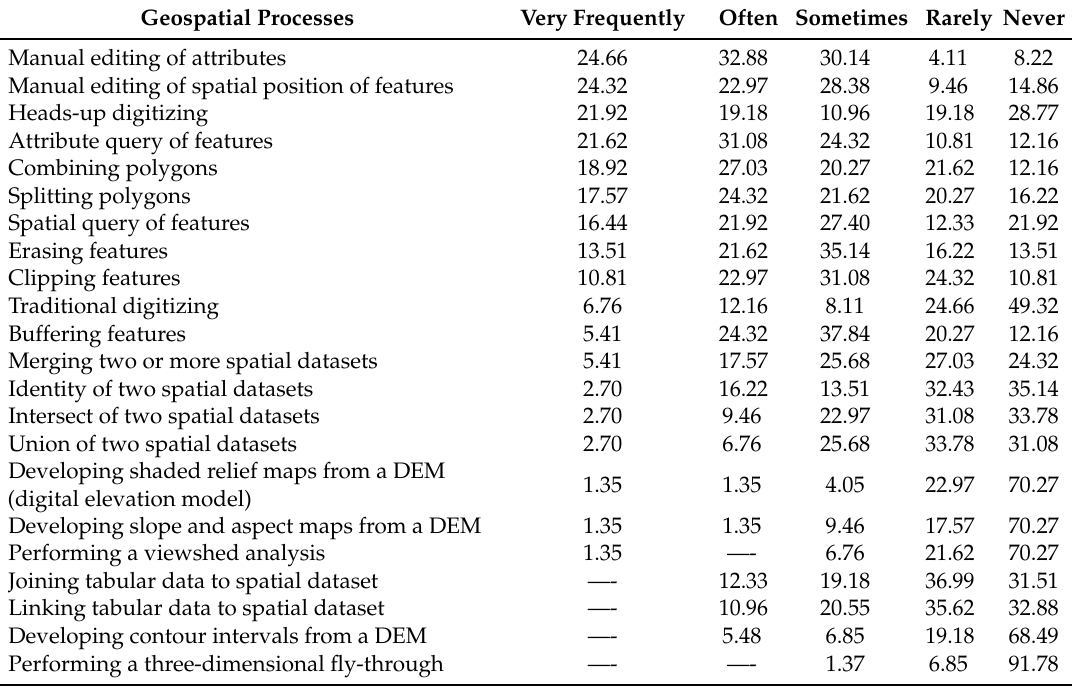
Table 2. GIS processes and frequency of use (percent of respondents) by recent graduates from forestry programs at Mississippi State University, Oregon State University, and the University of Georgia.